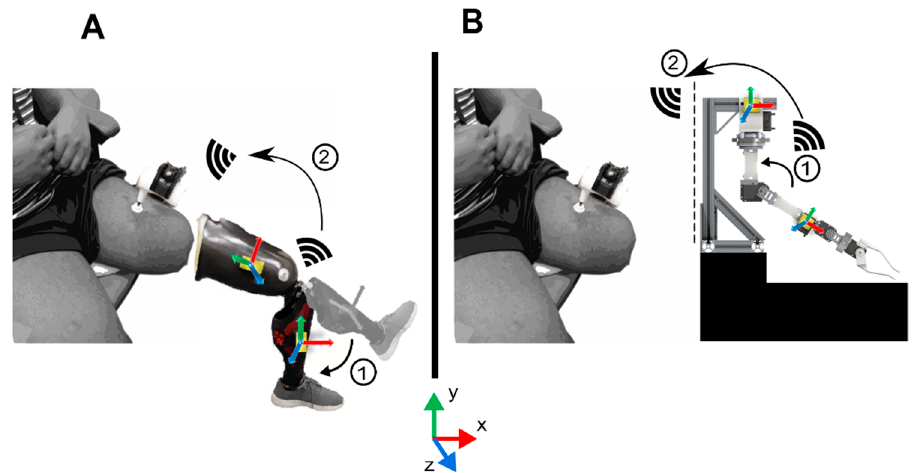
Figure 2. ( A ) The participant was shown his unattached prosthesis with the inertial measurement unit (IMU) modules attached proximally and distally of the knee joint. For each segment of the prosthesis, the orientation of the IMU module was calibrated as described in Section 2.1. The participant was informed that movement of the prosthesis, as detected by the wireless modules, was responsible for triggering the vibratory actuator. ( B ) The participant was unaware, however, that the robotic arm was used instead to provide motion measurements, triggering the vibration motor. The calibrated local coordinate frames and the global coordinate frame are shown within and below the figure, respectively.